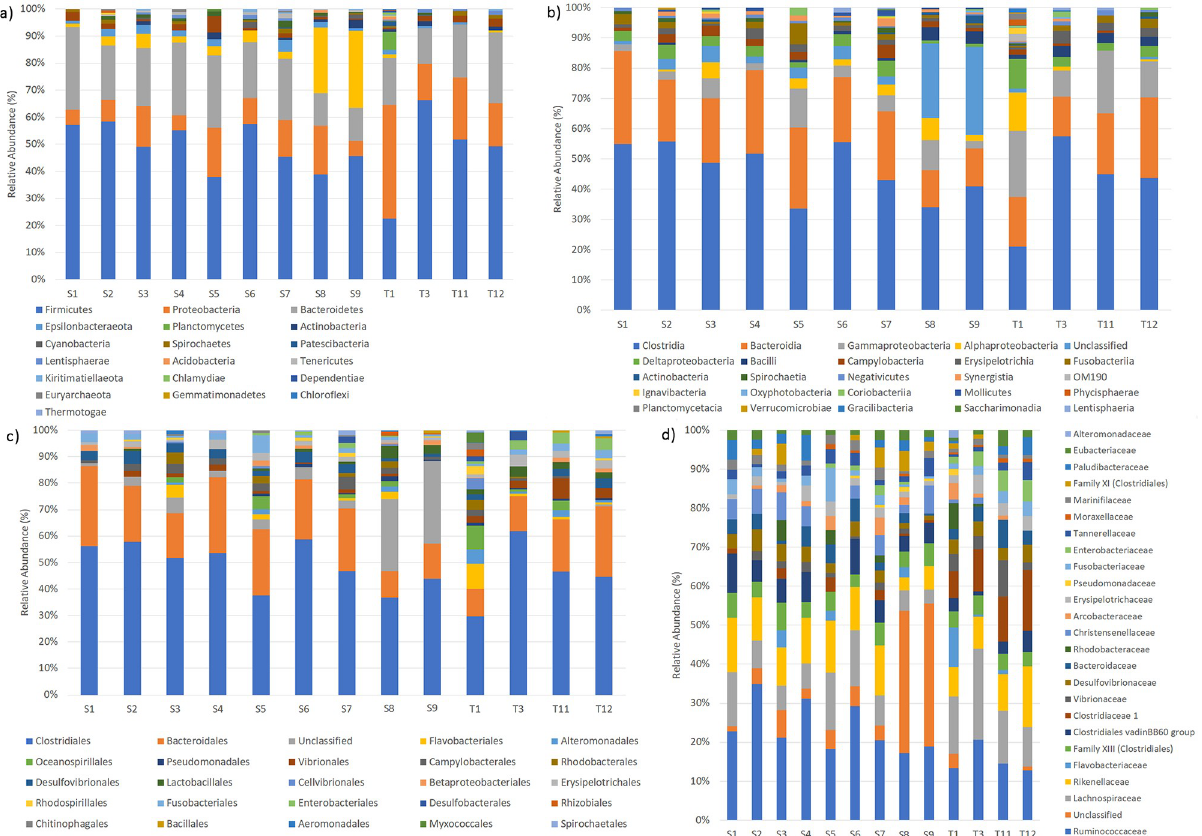
Fig 1. Relative abundance (%) of fecal bacterial communities in loggerhead sea turtles at different taxonomic levels. Microbial composition was determined taking into account only the 25 most abundant components of phylum (a), class (b), order (c) and family